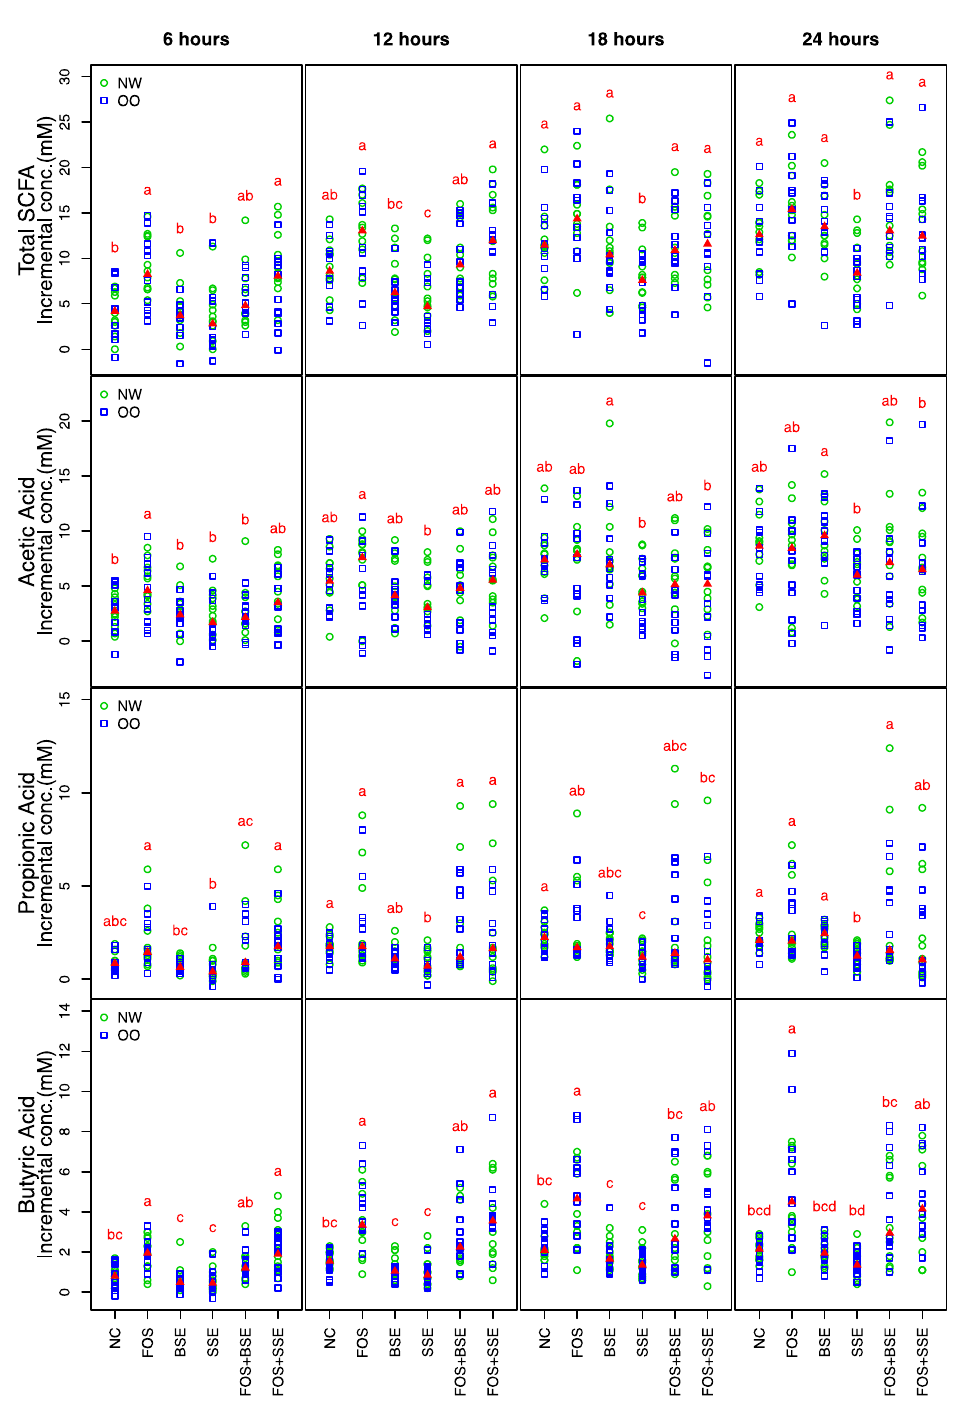
Figure 1. Total and individual SCFA during fermentation by treatment in both normal weight (NW, n = 11) and overweight/obese (OO, n = 11) samples. Different letters indicate significant differences between treatments, achieved by the Friedman test and its post hoc multiple comparisons at 0.05 level of significance. The medians are marked with red triangles. The weight classes (NW vs. OO) are labeled by green circles and blue squares, respectively. NC: negative control, FOS: fructooligosaccharides, BSE: black sorghum bran extract, SSE: sumac sorghum bran extract; SCFA: short-chain fatty